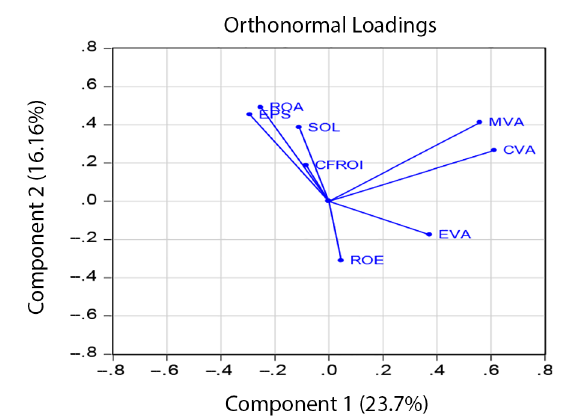
Figure 2. Orthonormal Loadings (source: authors’ calculation using Eviews